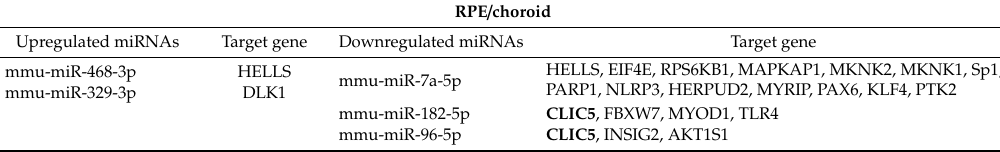
Table 11. The target genes predicted from the change in miRNA expression in the RPE / choroid.